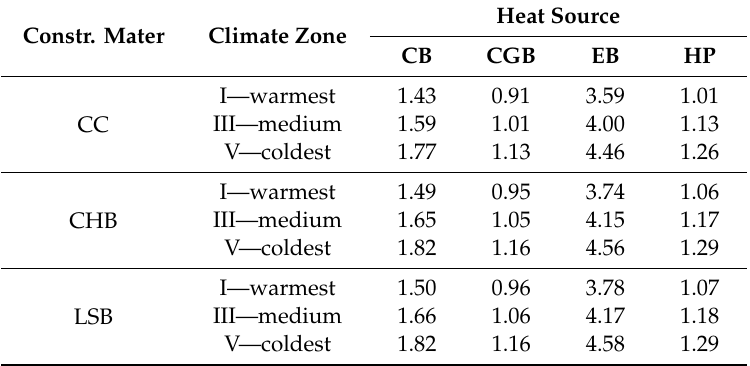
Table 7. Annual ecological heating cost G E [(Pt · K) / (W ·